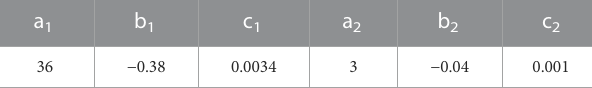
TABLE 5 Parameters of actual carbon emission